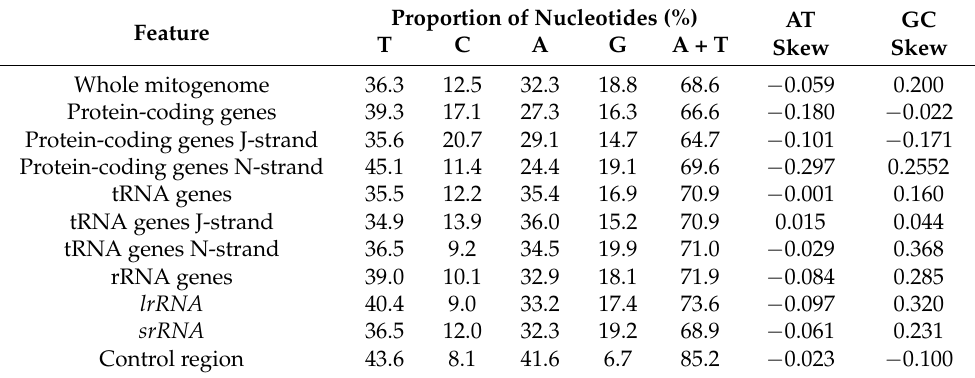
Table 3. The nucleotide composition of the M. flexura mitogenome.